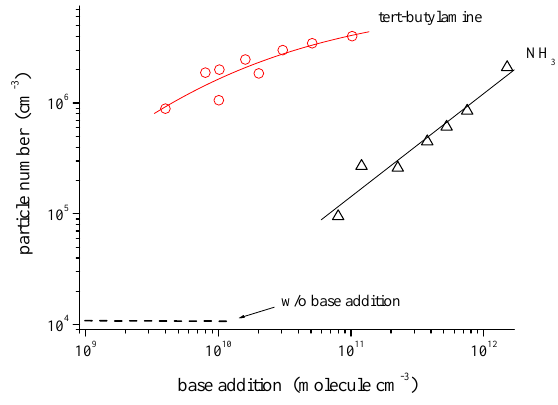
Fig. 12. Total particle numbers by integration of size distribu- tions as a function of base additions (NH 3 or tert-butylamine); total gas flow: 30lmin − 1 STP; Relative humidity: 13%; [H 2 SO 4 ]=8 × 10 8 moleculecm − 3